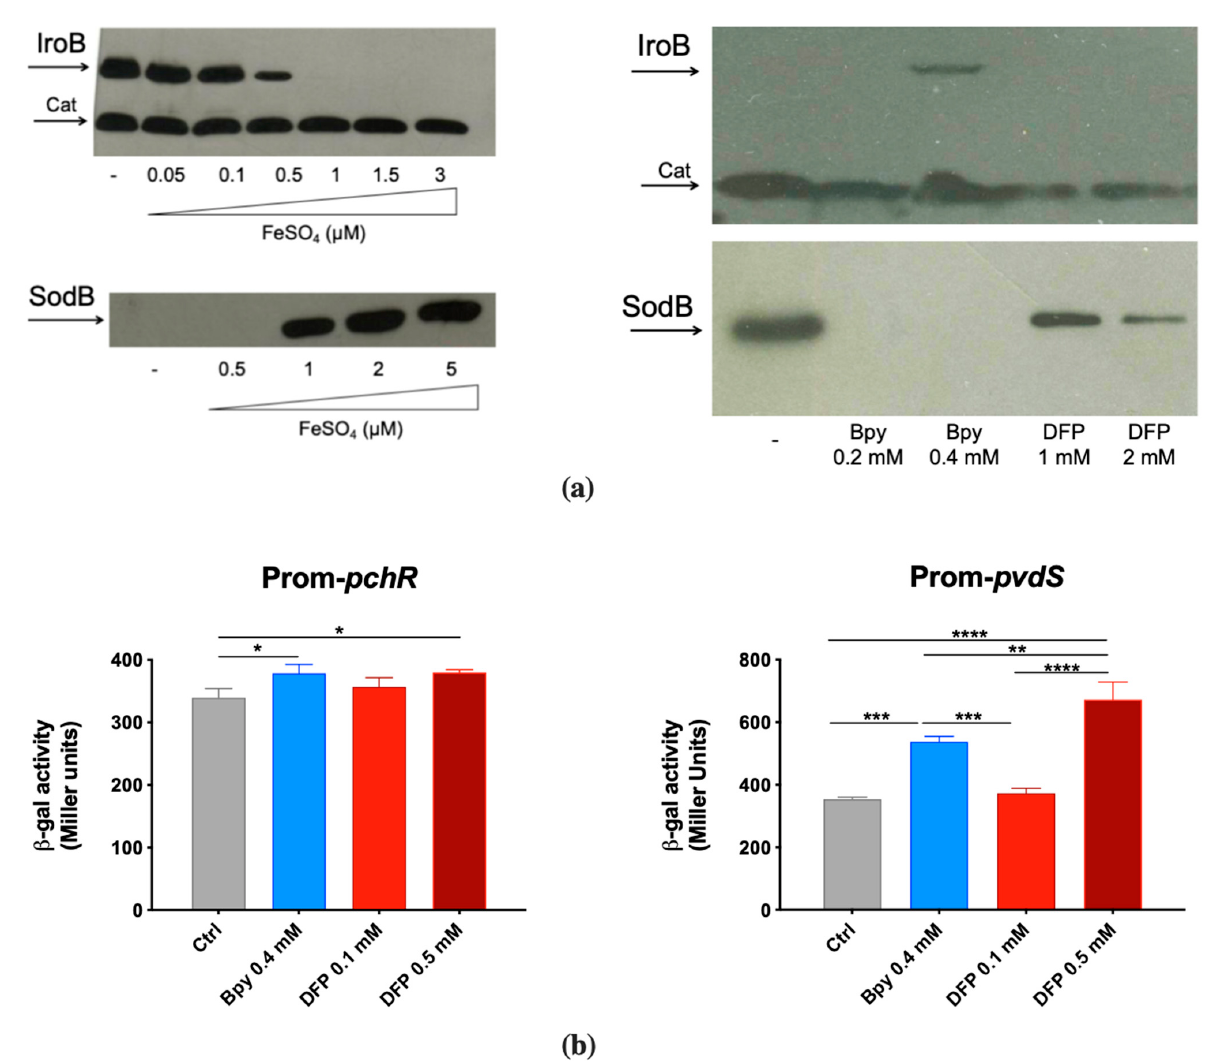
Figure 2. Responsiveness of Fur-regulated elements to DFP. ( a ) Western Blots of IroB and SodB proteins of STM from strains SA213 and MC120, respectively. Bacteria were grown for 18 h in M9 Minimal Medium supplemented with FeSO 4 (left) or in LB medium supplemented with Bpy or DFP (right) as indicated. In lysates from strain SA213 the Cat protein is taken as an internal loading control. ( b ) Transcriptional activity of pchR and pvdS promoters carried on the pMP220 reporter plasmid in PAO1. Bacteria were grown in LB medium supplemented with Bpy or DFP as indicated. Statistical significance (one-way ANOVA and Tukey’s multiple comparisons test): * p < 0.05; ** p < 0.01; *** p < 0.005 **** p < 0.0001.